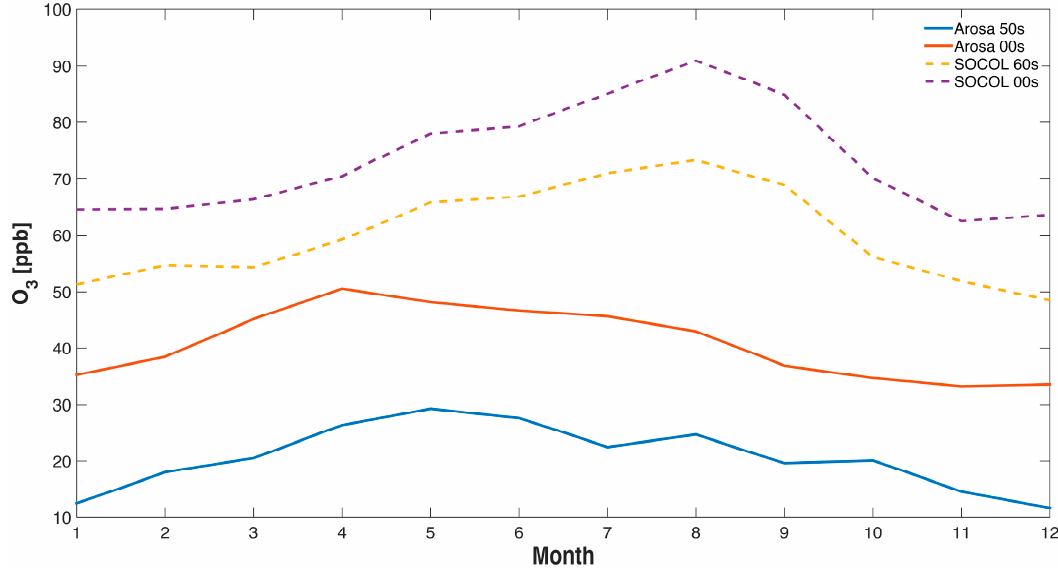
Figure 4. Annual cycle of ozone at Arosa, Switzerland, for various decades. Observations are available for the 1950s and 2000s (solid lines), while SOCOL results are shown for the 1960s and 2000s (dashed lines). The SOCOL data are extracted from the 850 hPa level.